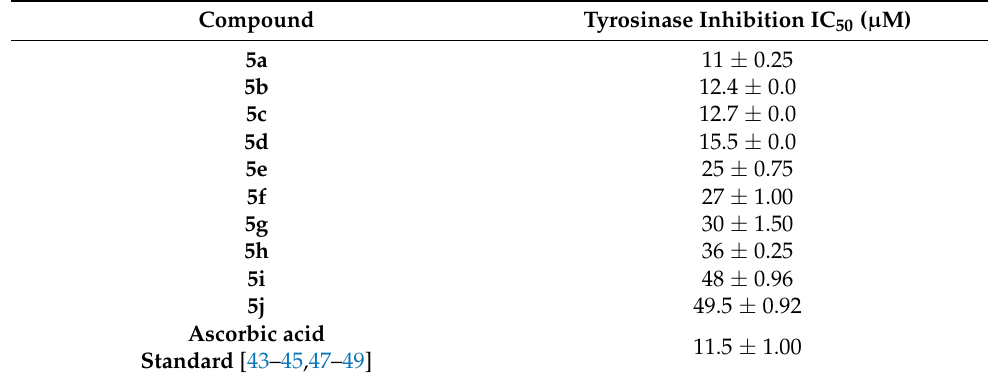
Table 2. Tyrosinase inhibition activity of oxadiazole-based furan molecules 5a–j